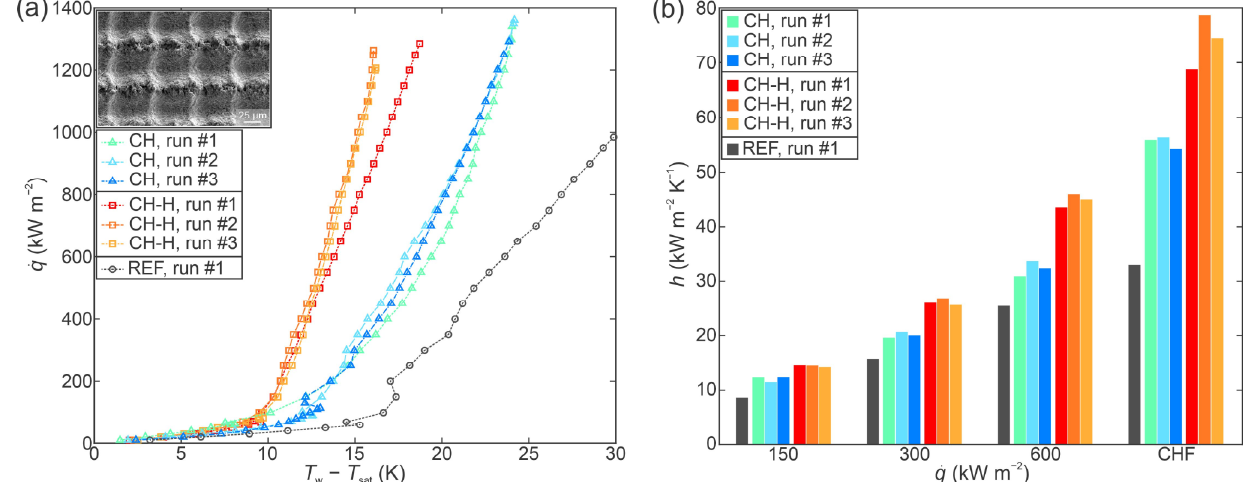
Figure 4. Boiling performance of the crosshatch sample (CH) evaluated through ( a ) boiling curves and ( b ) heat transfer coefficients at selected heat fluxes.